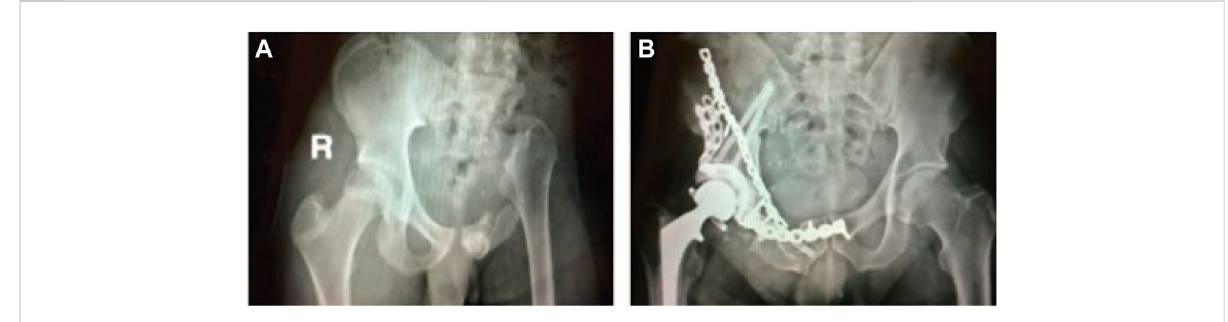
FIGURE 1 (A) Sample x-ray image of a pelvic cancer patient who received internal hemipelvectomy surgery with no reconstruction. (B) Sample x-ray image of a pelvic cancer patient who received internal hemipelvectomy surgery with allograph reconstruction and a total hip replacement. Images courtesy of Dr. Valerae Lewis, MD Anderson Cancer Center patient education